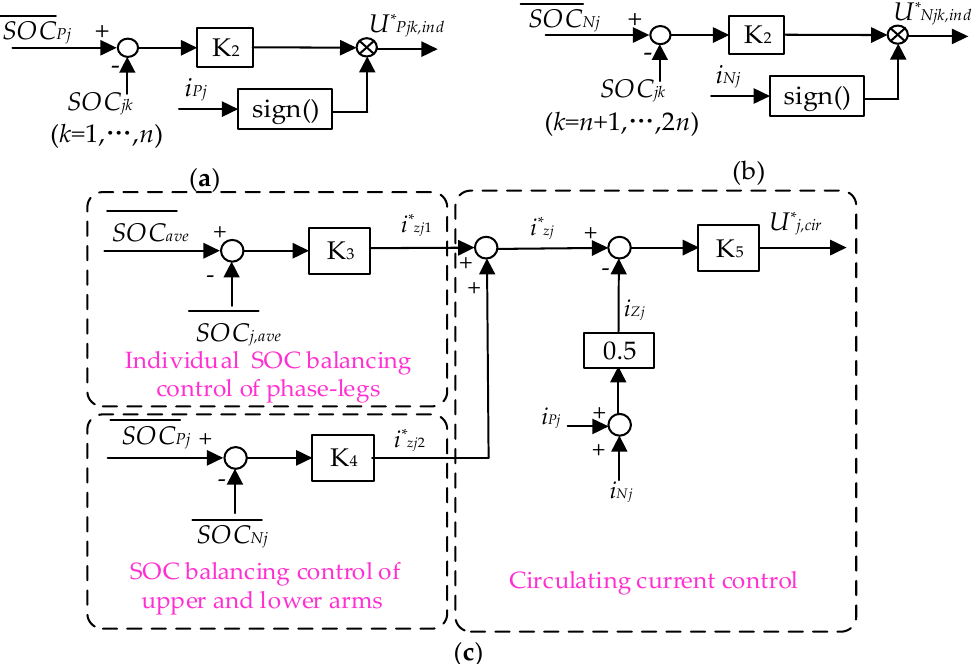
Figure 5. Block diagram of SOC control: ( a ) Individual SOC control (upper arm); ( b ) Individual SOC control (lower arm); ( c ) SOC balancing control.